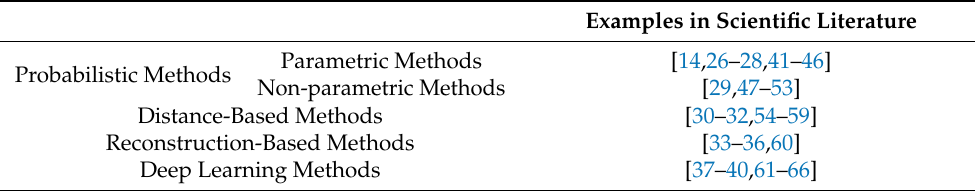
Table 1. Summary of the related work: novelty and anomaly detection